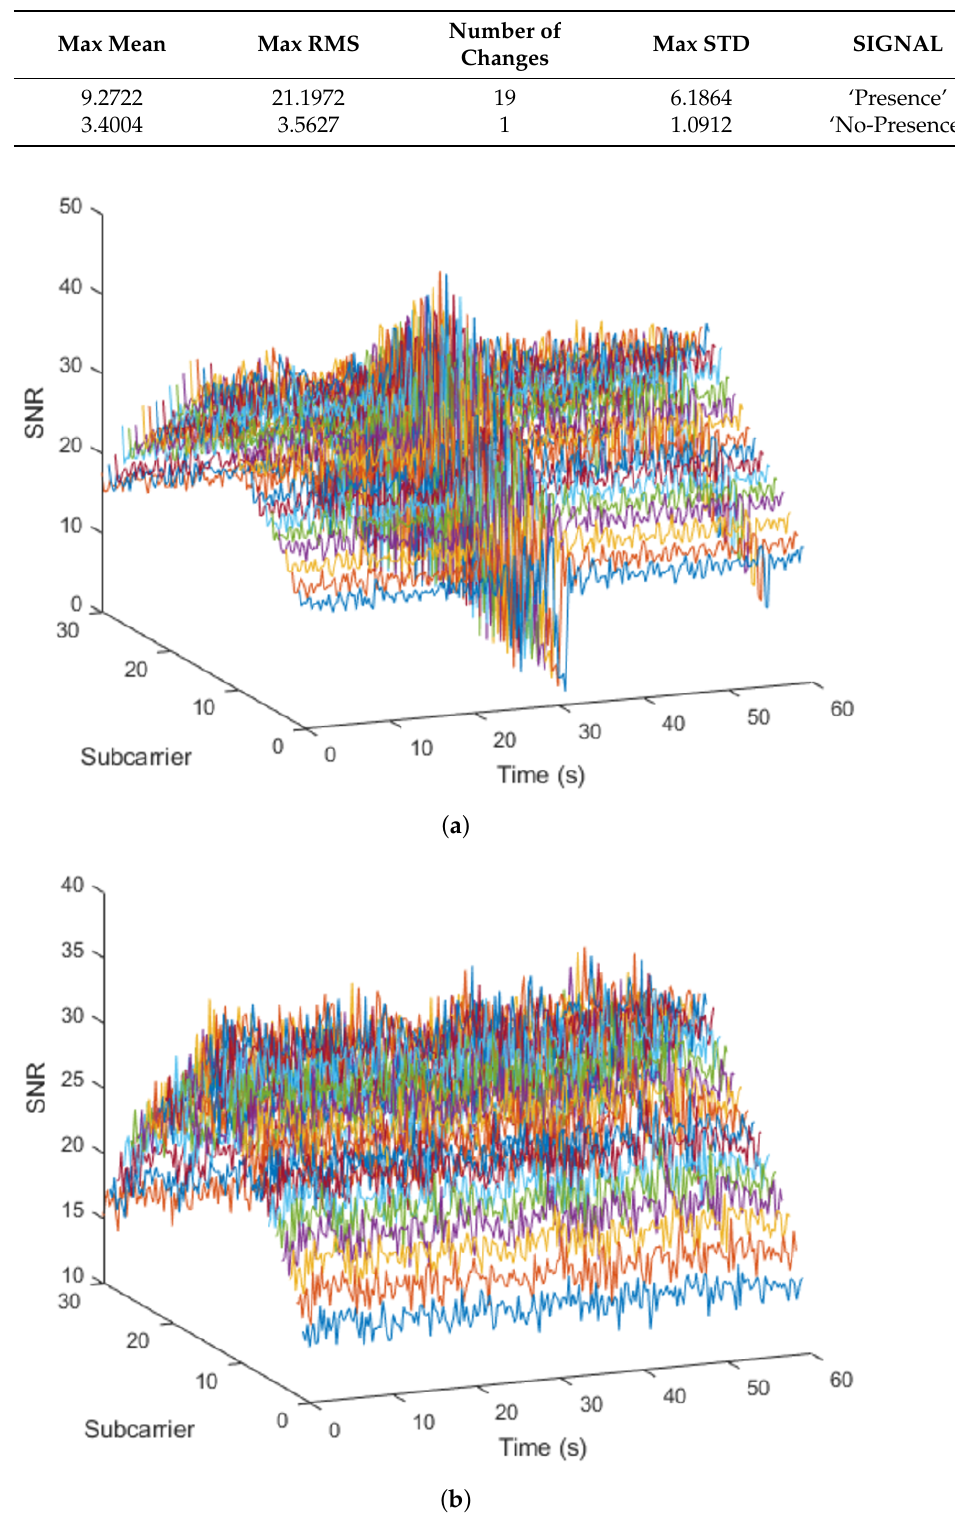
Table 1. Example of parameter results when there is human presence, and without it.